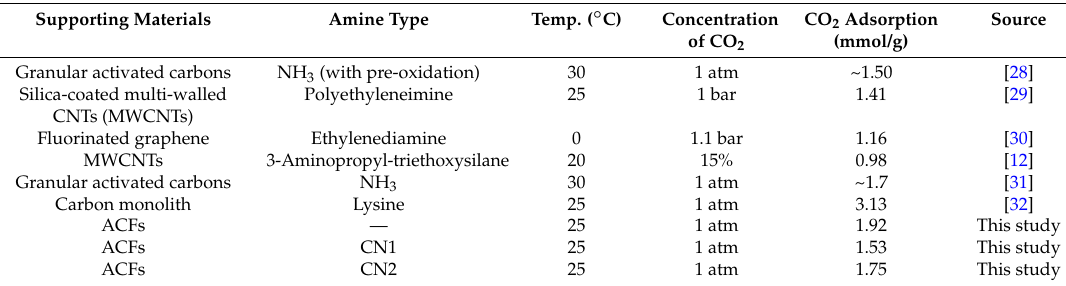
Table 5. Fitted parameters of three isotherm equations for CO 2 adsorption on CN2/ACF. Freundlich Langmuir Temp. ( o C)